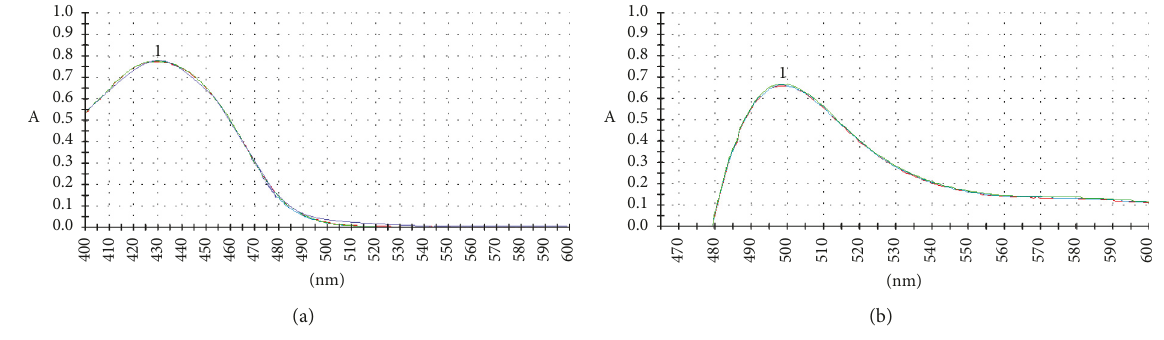
Figure 3: Absorption spectra of the Cur-Zn(II) (a) and Cur-Fe(III) (b). Table 1: The frequency of functional groups in curcumin and its complex in the IR spectrum. Groups